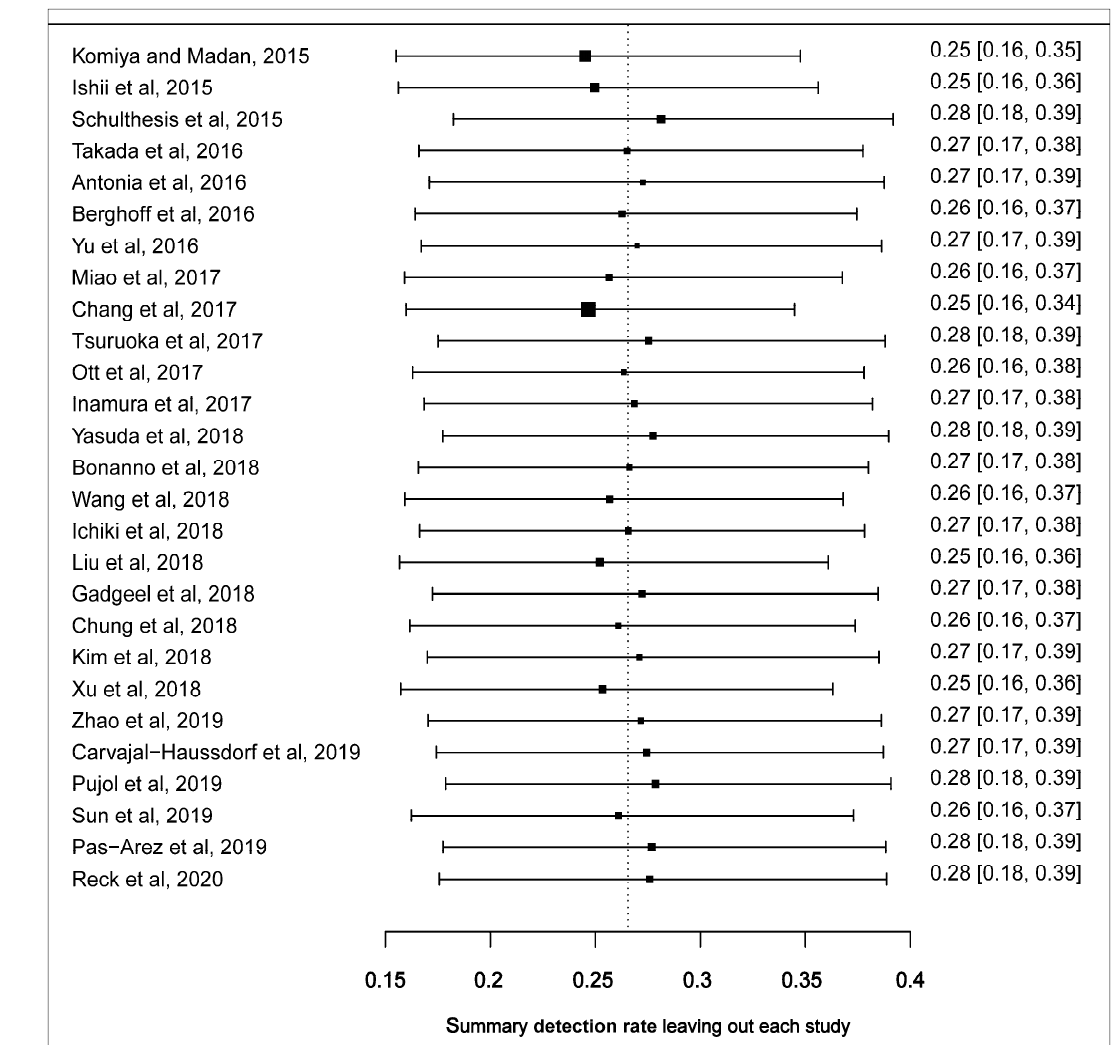
Figure 3. Leave-one-out sensitivity plot of studies reporting the prevalence of PD-L1 expression in SCLC. Each box depicts a summary of the calculated prevalence leaving out a study. The reference shows where the original summarised prevalence lies.